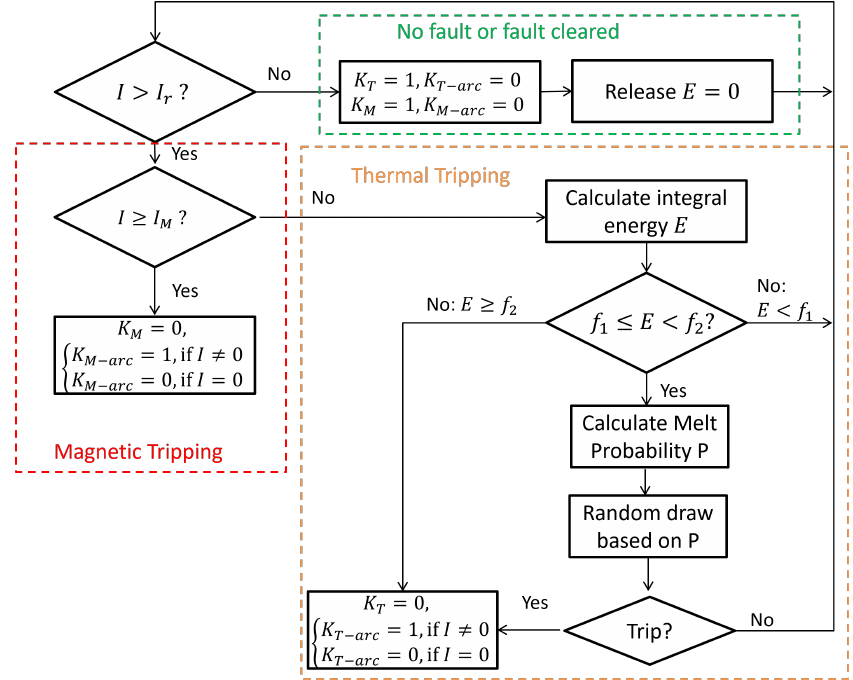
Figure 5. Operational flow chart of the probability-integrated TMCB